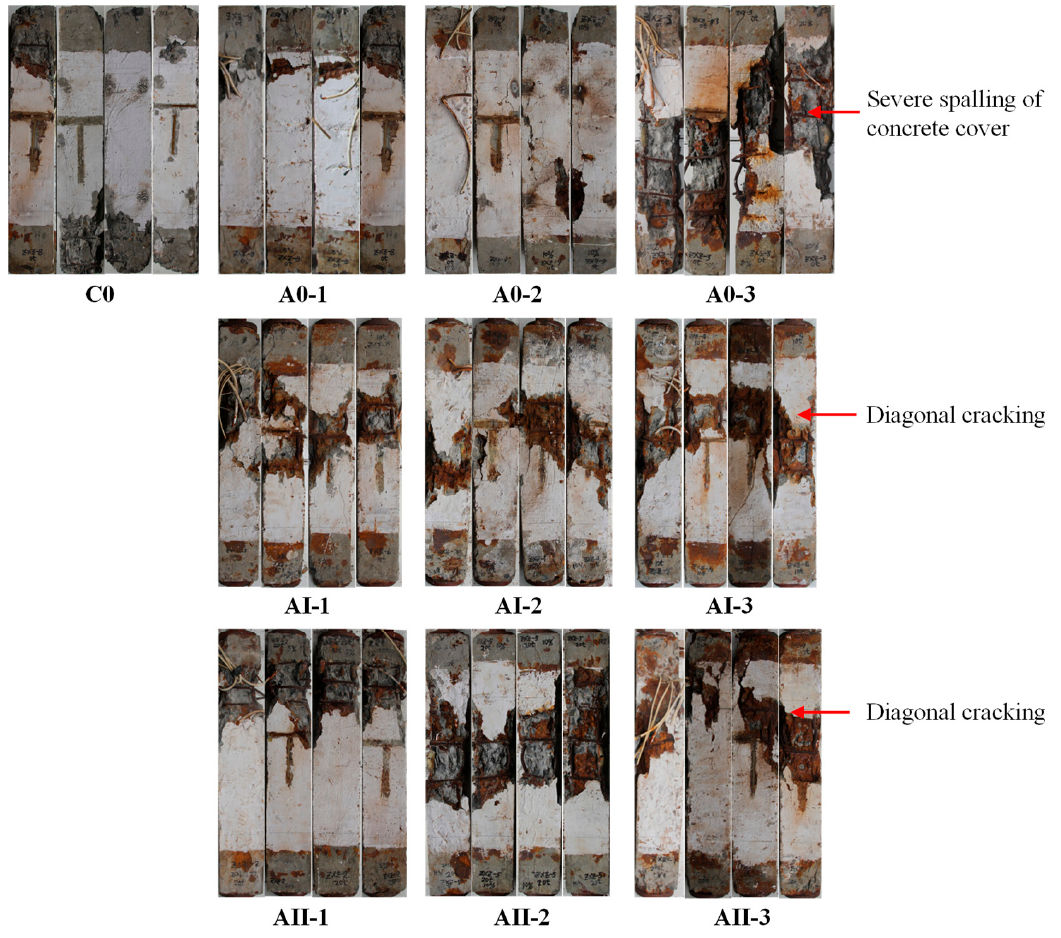
Figure 8. Failure characteristics of RC column specimens. The details for the value of sustained load and duration of corrosion tests for specimens C0, A0-1, A0-2, A0-3, AI-1, AI-2, AI-3, AII-1, AII-2, AII-3 are listed in Table